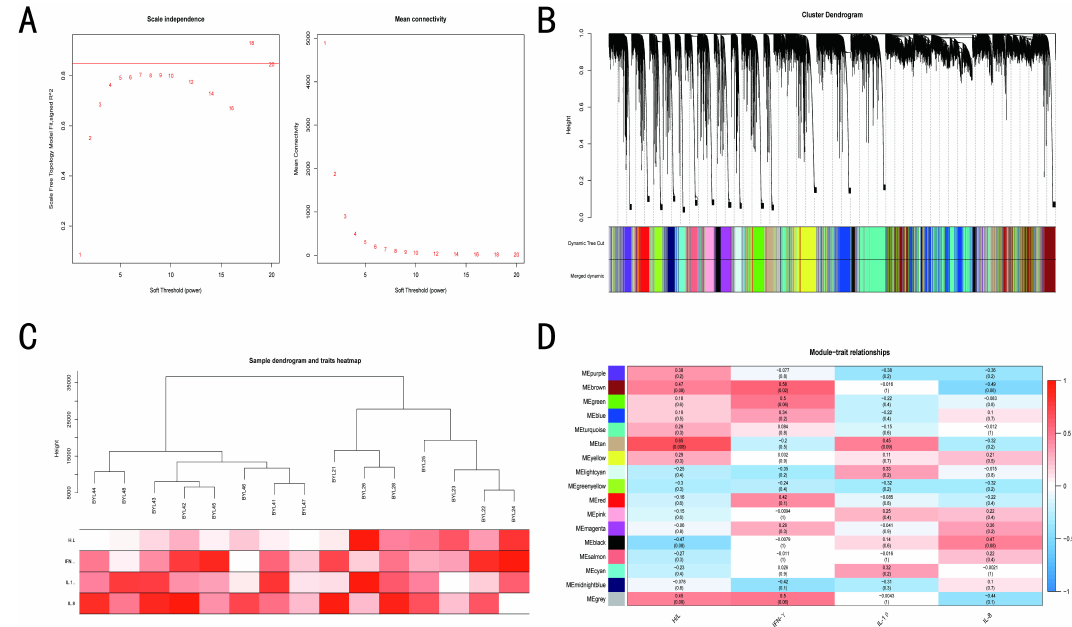
Figure 4. WGCNA results of BY show the modules significantly correlated with treatment (ST infection) and blood indicators (H/L, IL-1 β , IL-8 and IFN- γ ). ( A ) Analysis of network topology for various soft-thresholding powers. ( B ) Clustering dendrogram of genes, with dissimilarity based on topological overlap, together with assigned module colors. ( C ) Eigengene dendrogram and eigengene adjacency plot. ( D ) Module-trait associations. Each row corresponds to a module, and each column corresponds to a trait. Each cell contains the corresponding correlation and p -value.